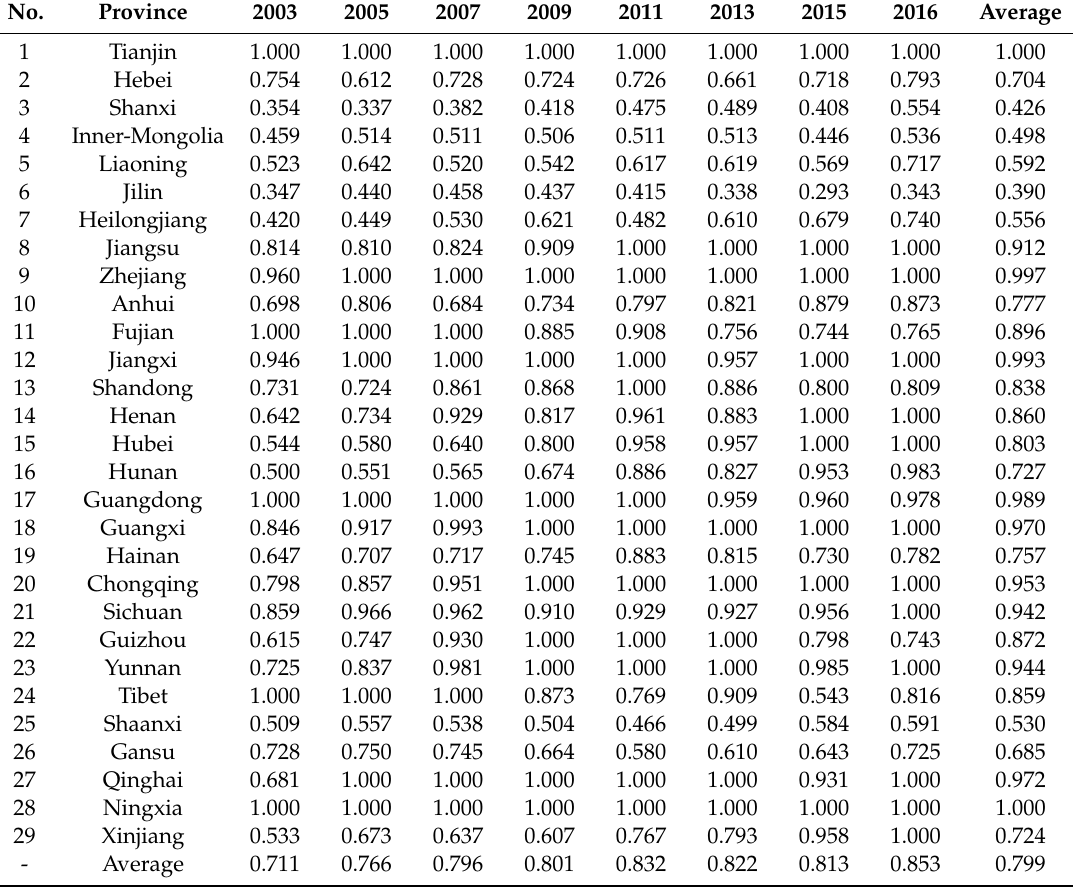
Table 2. Provincial e ffi ciency of Chinese township hospitals